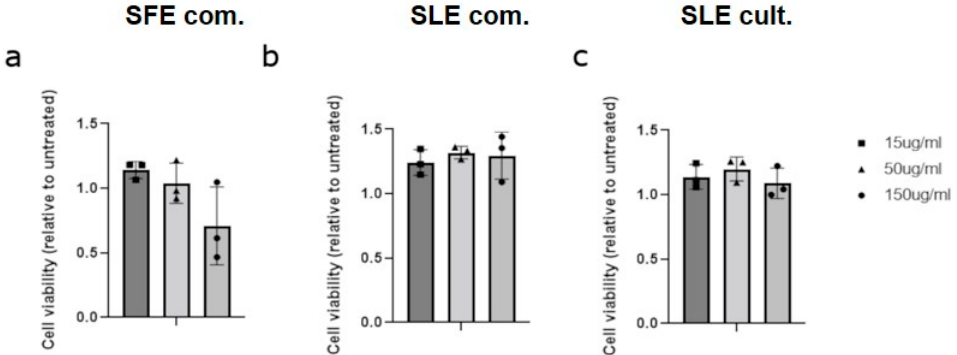
Figure 3. Effect of C. vulgaris extracts obtained by different extraction methods on cell viability. Quantification of cell viability of human mesenchymal stem cells (MSCs) treated with C. vulgaris ( a ) SFE; ( b ) maceration commercially available and ( c ) maceration laboratory cultivated for 24 h examined by cell viability assay. Data represent mean ± SEM (Comparisons by ANOVA with Tukey’s multiple comparisons test, n = 3 independent experiments).